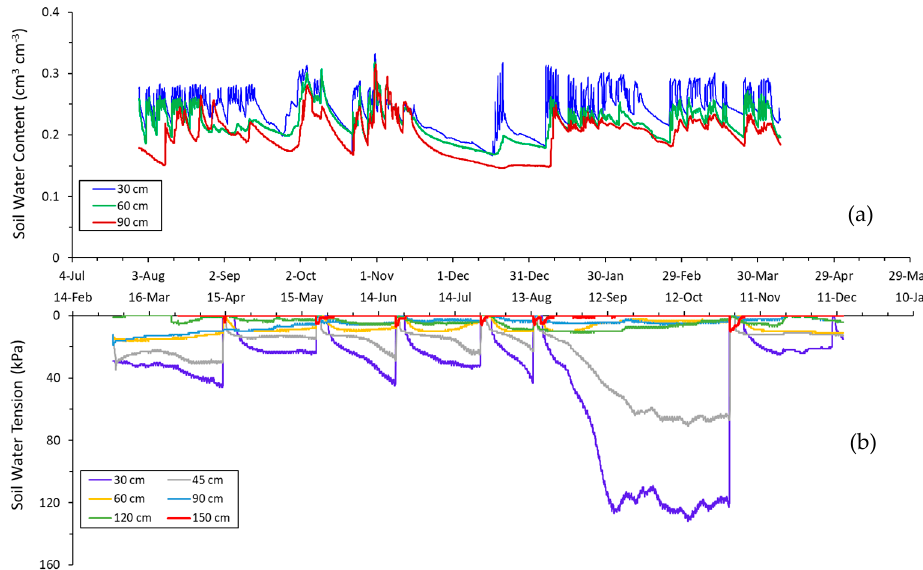
Figure 8. Half-hourly ( a ) soil volumetric water content (cm 3 cm − 3 ) measured at depths of 30 cm, 60 cm, and 90 cm at the Date Palm 3 (DP3) site and ( b ) soil water tension (kPa) measured at depths of 30 cm, 45 cm, 60 cm, 90 cm, 120 cm, and 150 cm at the Date Palm 6 (DP6) site. The soil water tension data is reported for the DP6 site to show the soil saturated condition in the deeper depth (150 cm) where no TEROS 12 sensor was available to measure soil volumetric water content. Soil water content at field capacity (FC) and permanent wilting point (PWP) at the site DP3 is approximately 0.09 and 0.23 cm 3 cm − 3 , respectively; and at the site DP6, soil water tension at FC is nearly 13 kPa and at PWP is more than 200 kPa.